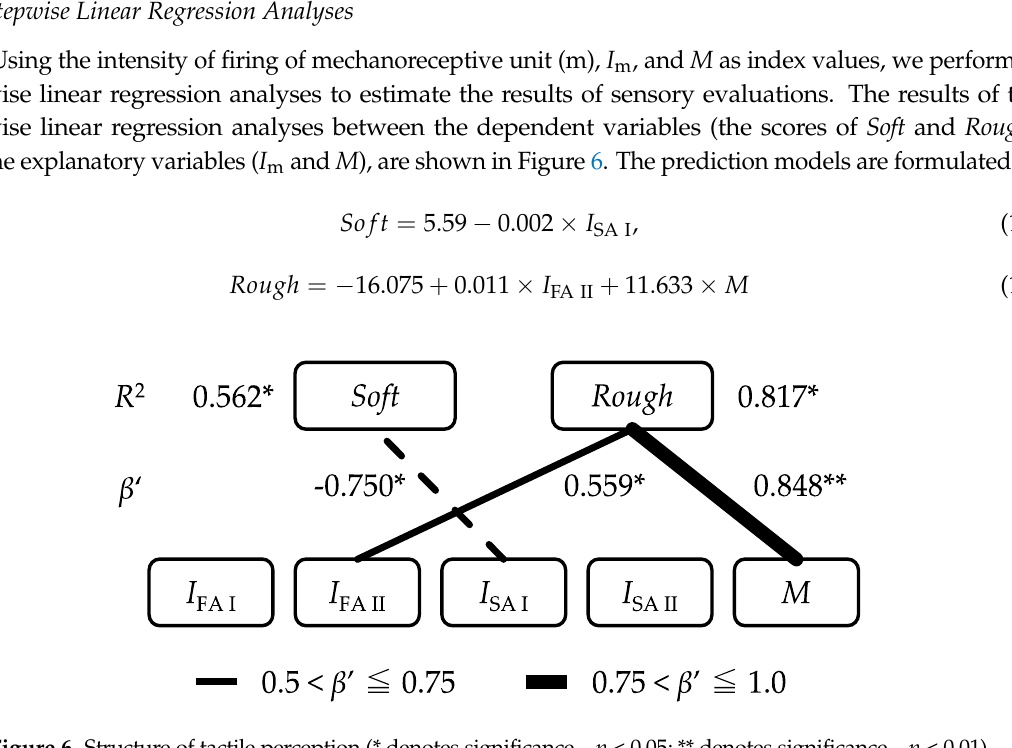
Figure 6. Structure of tactile perception (* denotes significance — p < 0.05; ** denotes significance — p < 0.01). The positive values of β ’ are shown using solid lines, and the negative values using dotted lines.